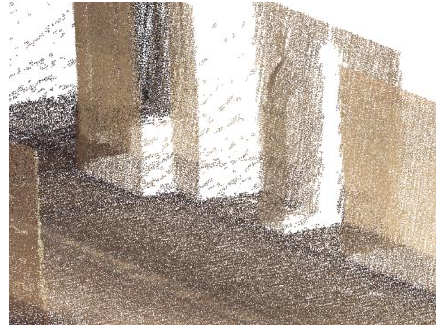
Figure 7 Leica Pegasus backpack point cloud